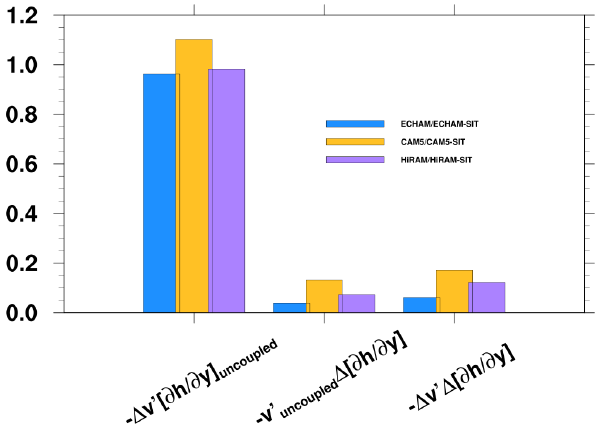
Figure 12. Bar chart of the relative contribution of intraseasonal convergence and background moisture between the coupled and un- coupled changes in MJO phase